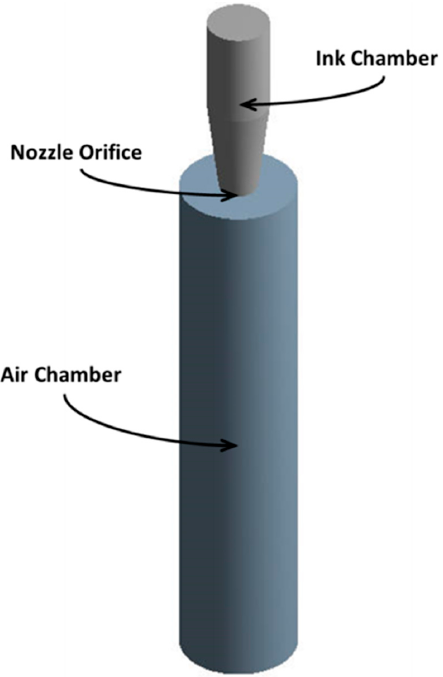
Figure 1. Schematic of the computational domain.